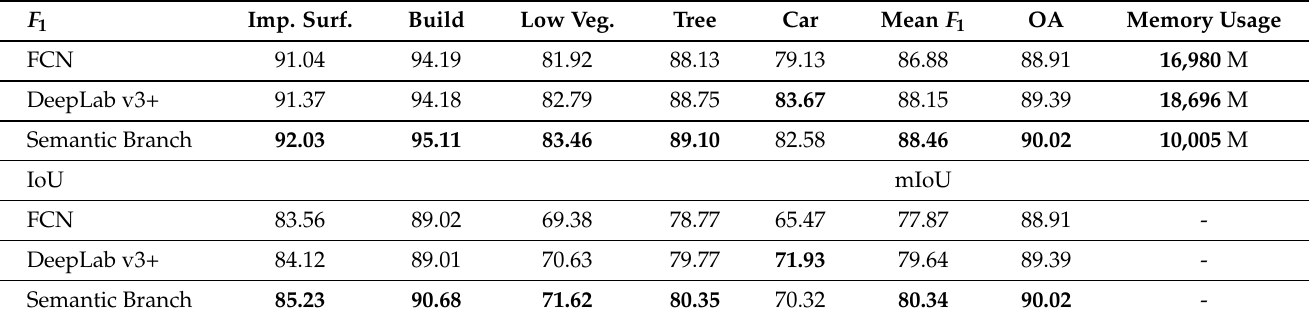
Table 3. Comparison of FCN, semantic branch, and DeepLab v3+ on Vaihingen dataset.